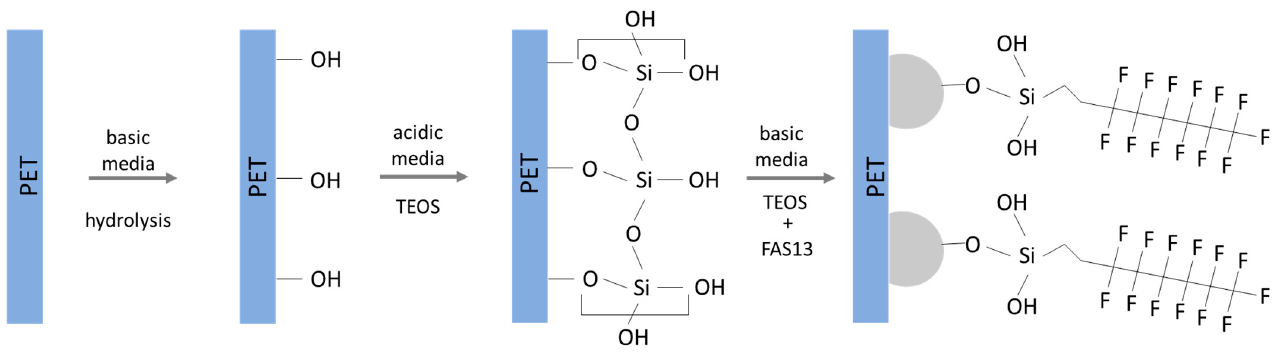
Figure 1. Reaction mechanism proposed for the in situ growth of fluorinated silica NPs on hydrolysed PET.